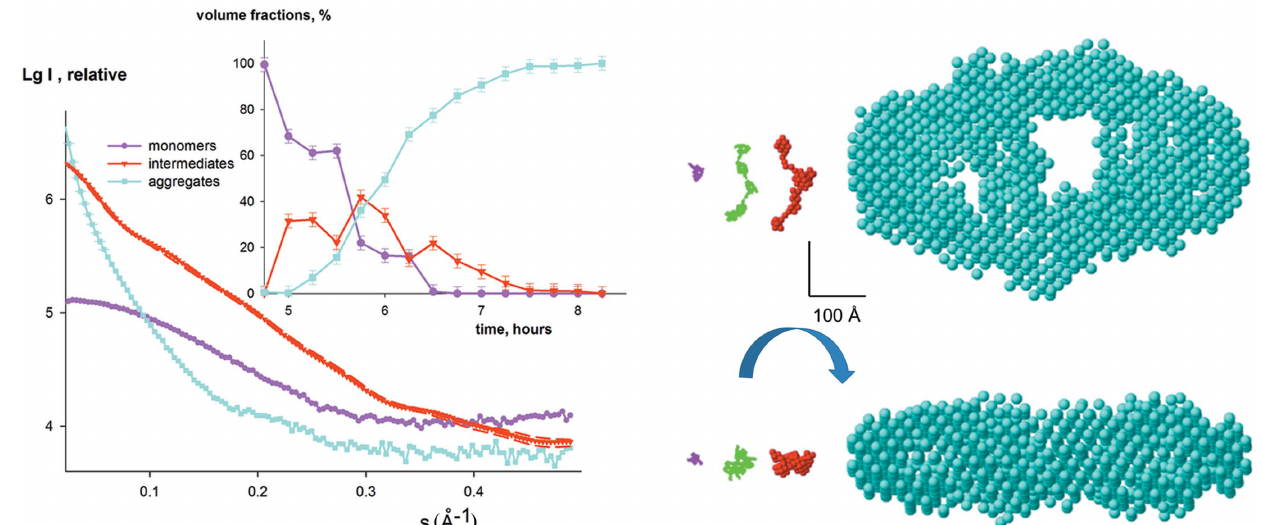
Figure 2 Analysis of the intermediate during insulin fibrillation. The initial state is well represented by a monomeric model of insulin (PDB entry 1guj) and the final state is approximated by the bead model of the mature fibril (Vestergaard et al. , 2007). The top left panel displays the experimental data (dots with error bars), and the DAMMIX fits as red solid lines. The shapes of the monomer and the aggregates are shown in the bottom right panel with magenta and cyan beads, respectively; the previously reported intermediate pentameric model is displayed with a green C (cid:3) trace (Vestergaard et al. , 2007). The restored shape of the unknown intermediate obtained by DAMMIX is displayed in the bottom right panel (red beads). The scale bar is 100 A˚ . The scattering curves from the components are shown in the bottom left panel (the two most different restored curves for the intermediate obtained from multiple DAMMIX runs are shown with dashed red lines) and their restored volume fractions are displayed as an inset; the colours are the same as the bottom right panel and the error bars of volume fractions display the average dispersion over multiple DAMMIX